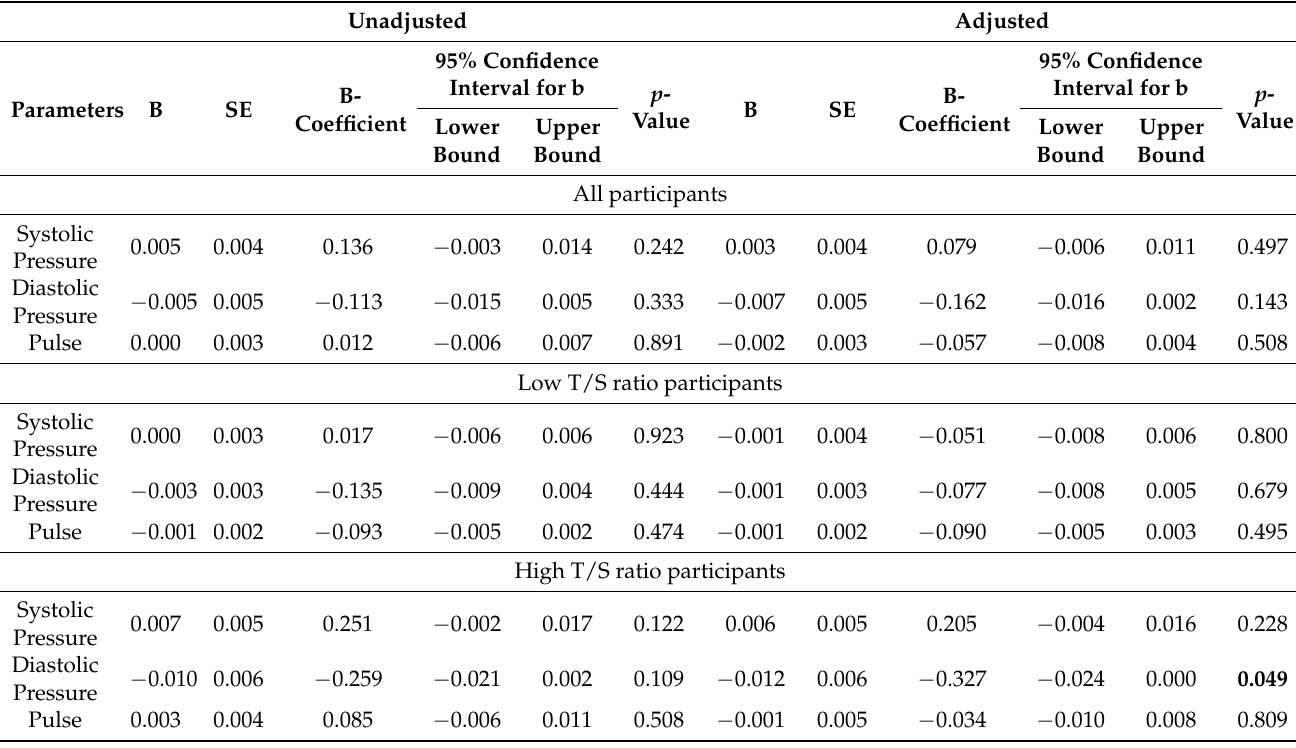
Figure 5. Comparison of blood pressure in EA and AA children with low and high T/S ratios. Bar graphs shows the differences in blood pressure in EA and AA participants with ( a ) the low T/S ratio and ( b ) the high T/S ratio. Values are expressed as mean ± SEM. Table 2. The relationship between T/S ratio and blood pressure by hierarchical regression analysis (Adjusted for race, gender, and